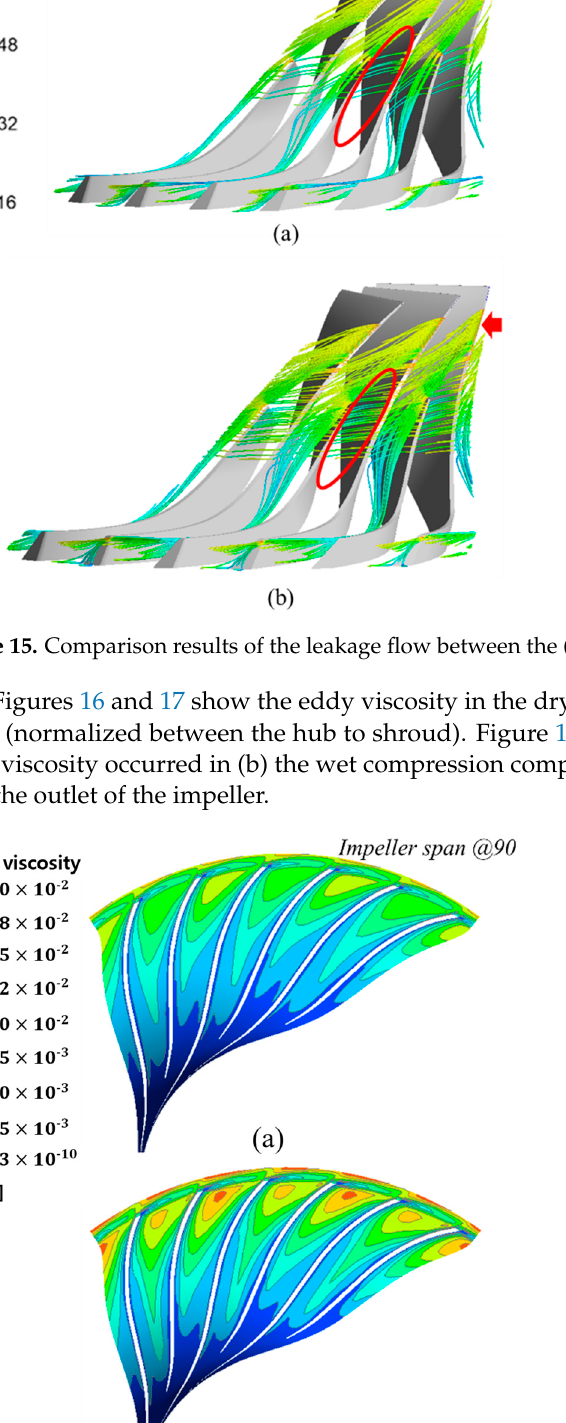
Figure 17. Diffuser eddy viscosity distribution between the ( a ) dry and ( b ) wet compression at the stall region . 5.2. Performance Analysis at the Off-Design Operating Condition Figure 18 shows the performance according to the size of the droplet to analyze the performance according to the size of the droplet at the off-design point. As with the design point, the size of the droplet was changed from 1 to 10 μ m to confirm the flow rate, outlet temperature, pressure ratio, and isentropic efficiency. Unlike the design point, it showed the best performance at 1 μ m in the surge area. Results also showed that the performance decreases as the droplet diameter increases. When the droplet diameter grows, the num- ber of droplets that have not evaporated inside the centrifugal compressor influences per- formance, just as it does with the design point. Figure 19 shows the average volume frac- tion in the direction of the streamwise, and the droplet diameter with 1 μ m evaporated at the streamwise location of 0.6. On the other hand, when the droplet diameter was 10 μ m,